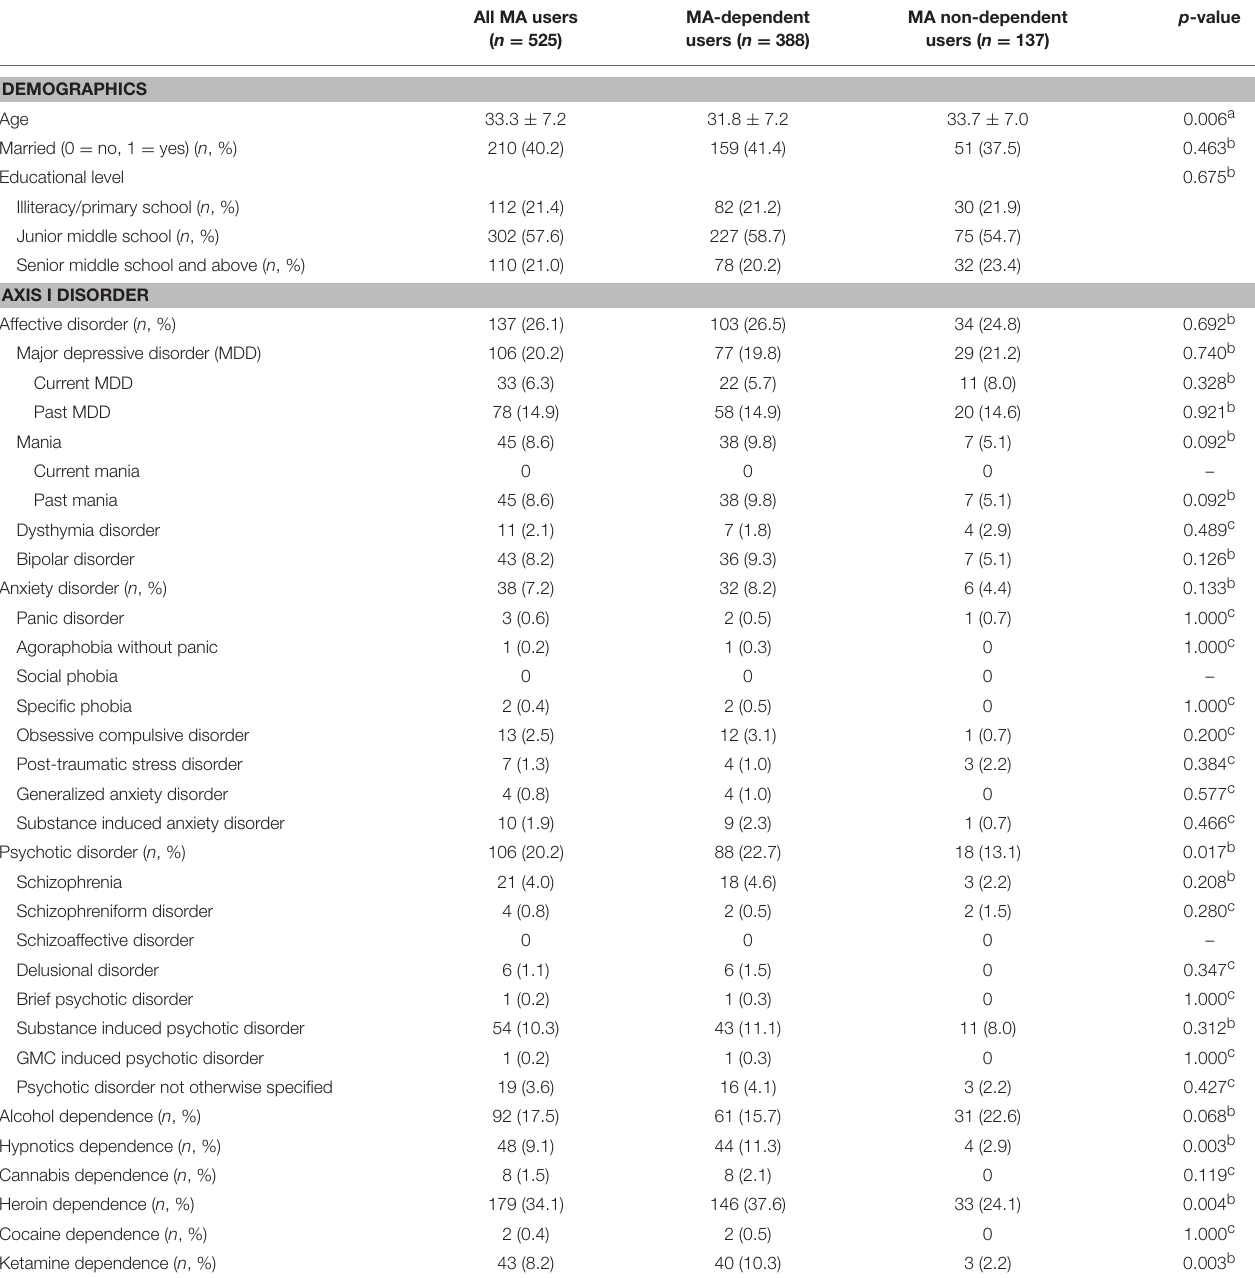
TABLE 1 | Demographic and clinical data of the study sample.